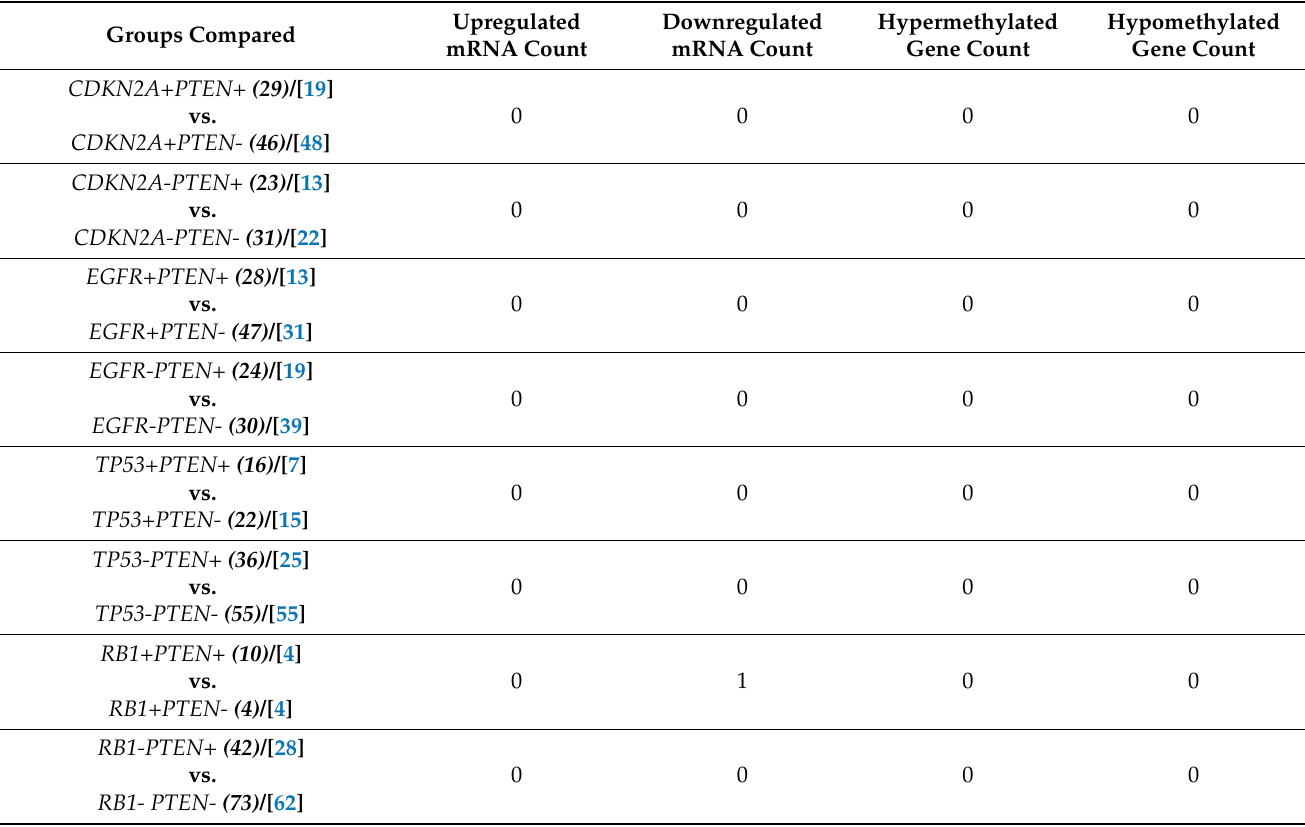
Table 5. The influence of the presence or absence of concurrent DAs in four driver genes (other than PTEN ) on the associations between DAs in PTEN with DEMs and DMGs. The numbers in round parentheses adjacent to a group represent the number of cases of that group in C1 that were used to compare differentially expressed mRNA. The numbers in square parentheses adjacent to a group represent the number of cases of that group in C2 that were used to compare differentially methylated